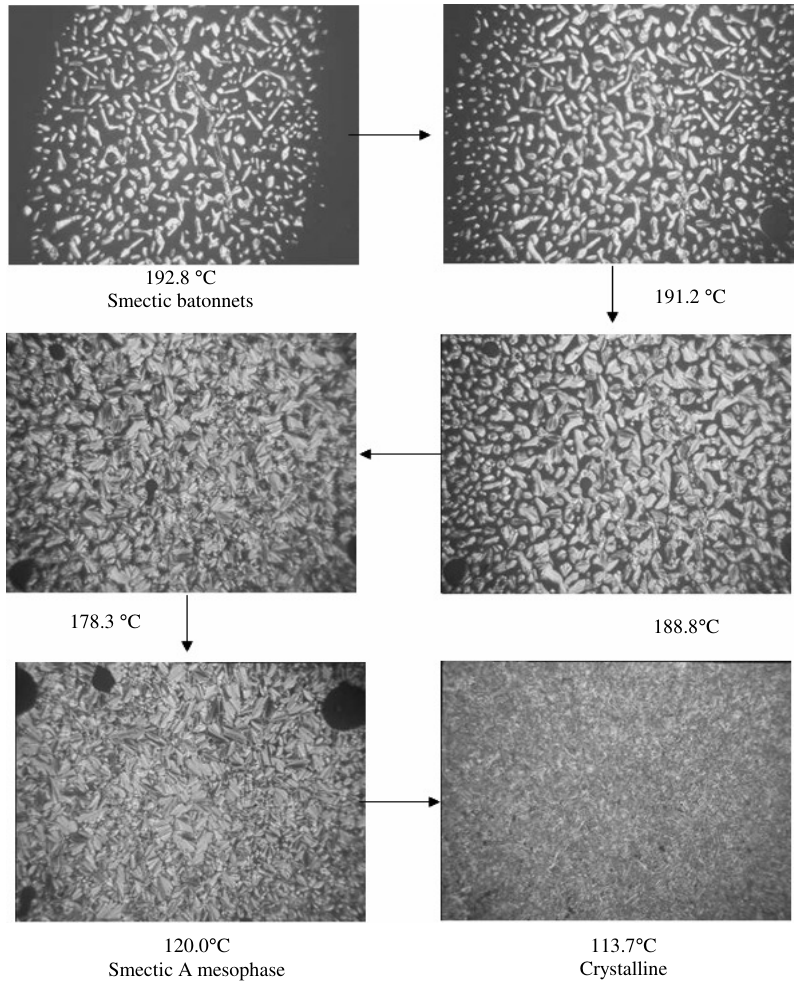
Figure 1 . The representative HOPM photograph of IIb showing the mesophase formation while cooling from isotropic liquid-Smectic A-Crystalline thermal